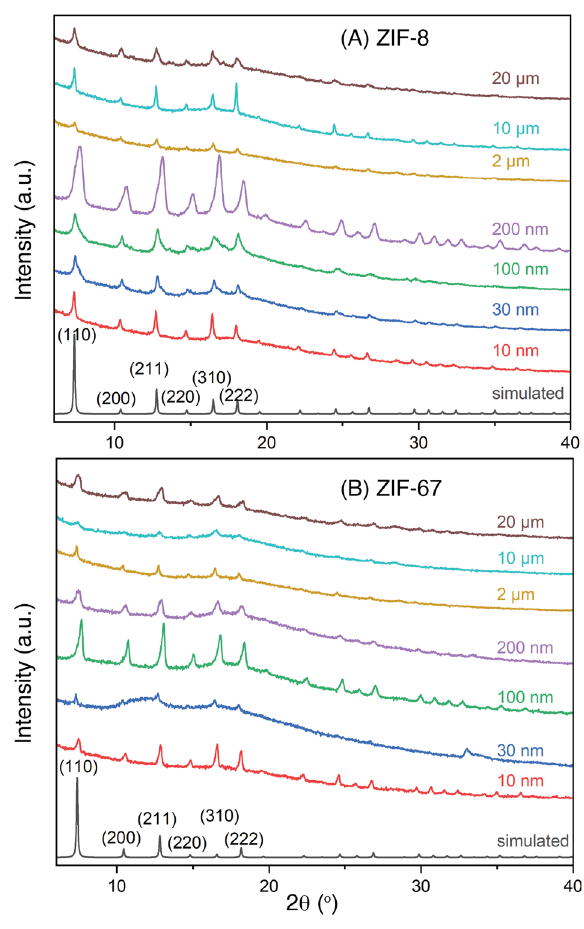
Fig. 2 X-ray diffraction (XRD) characterization. XRD patterns of track- etched polycarbonate (PCTE) templates of various pore sizes containing ( A ) ZIF-8 and ( B ) ZIF-67 nano- and micro-structures after interfacial